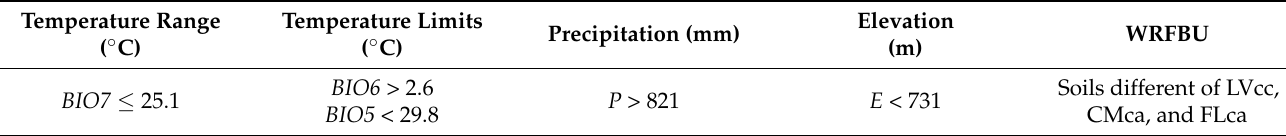
Table 5. Maritime pine potential distribution (i.e., ecological envelope)—new thresholds obtained by ML classification tree algorithm